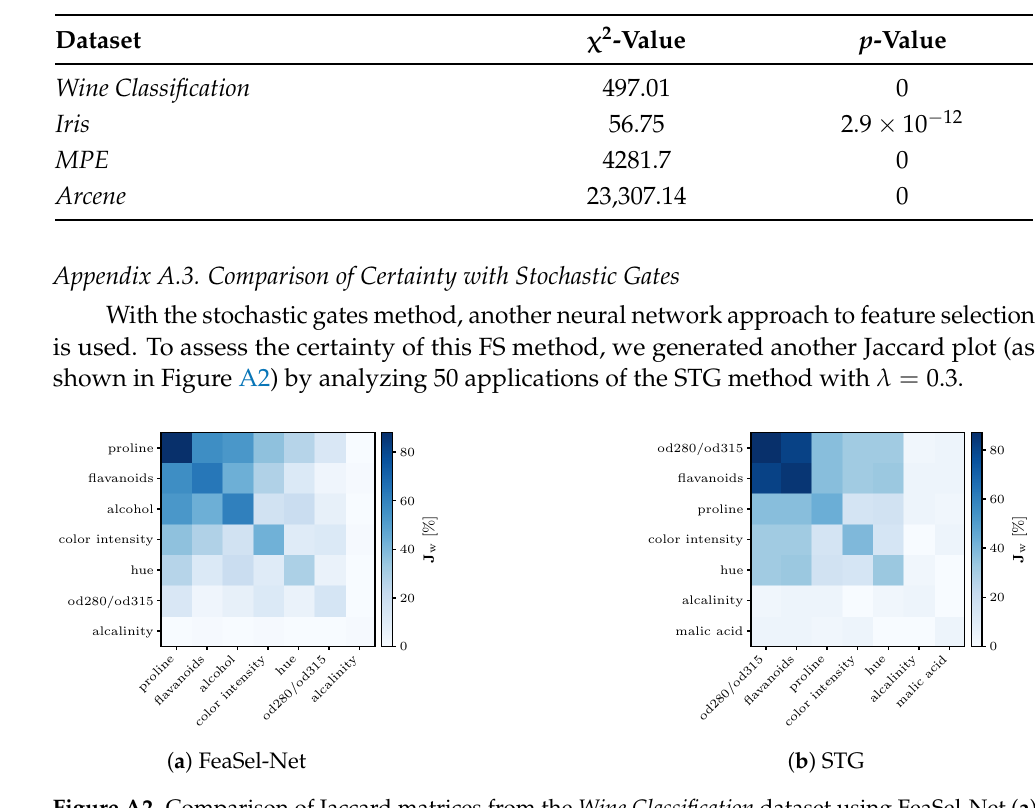
Table A1. Statistical χ 2 test applied on the feature sets selected by FeaSel-Net.